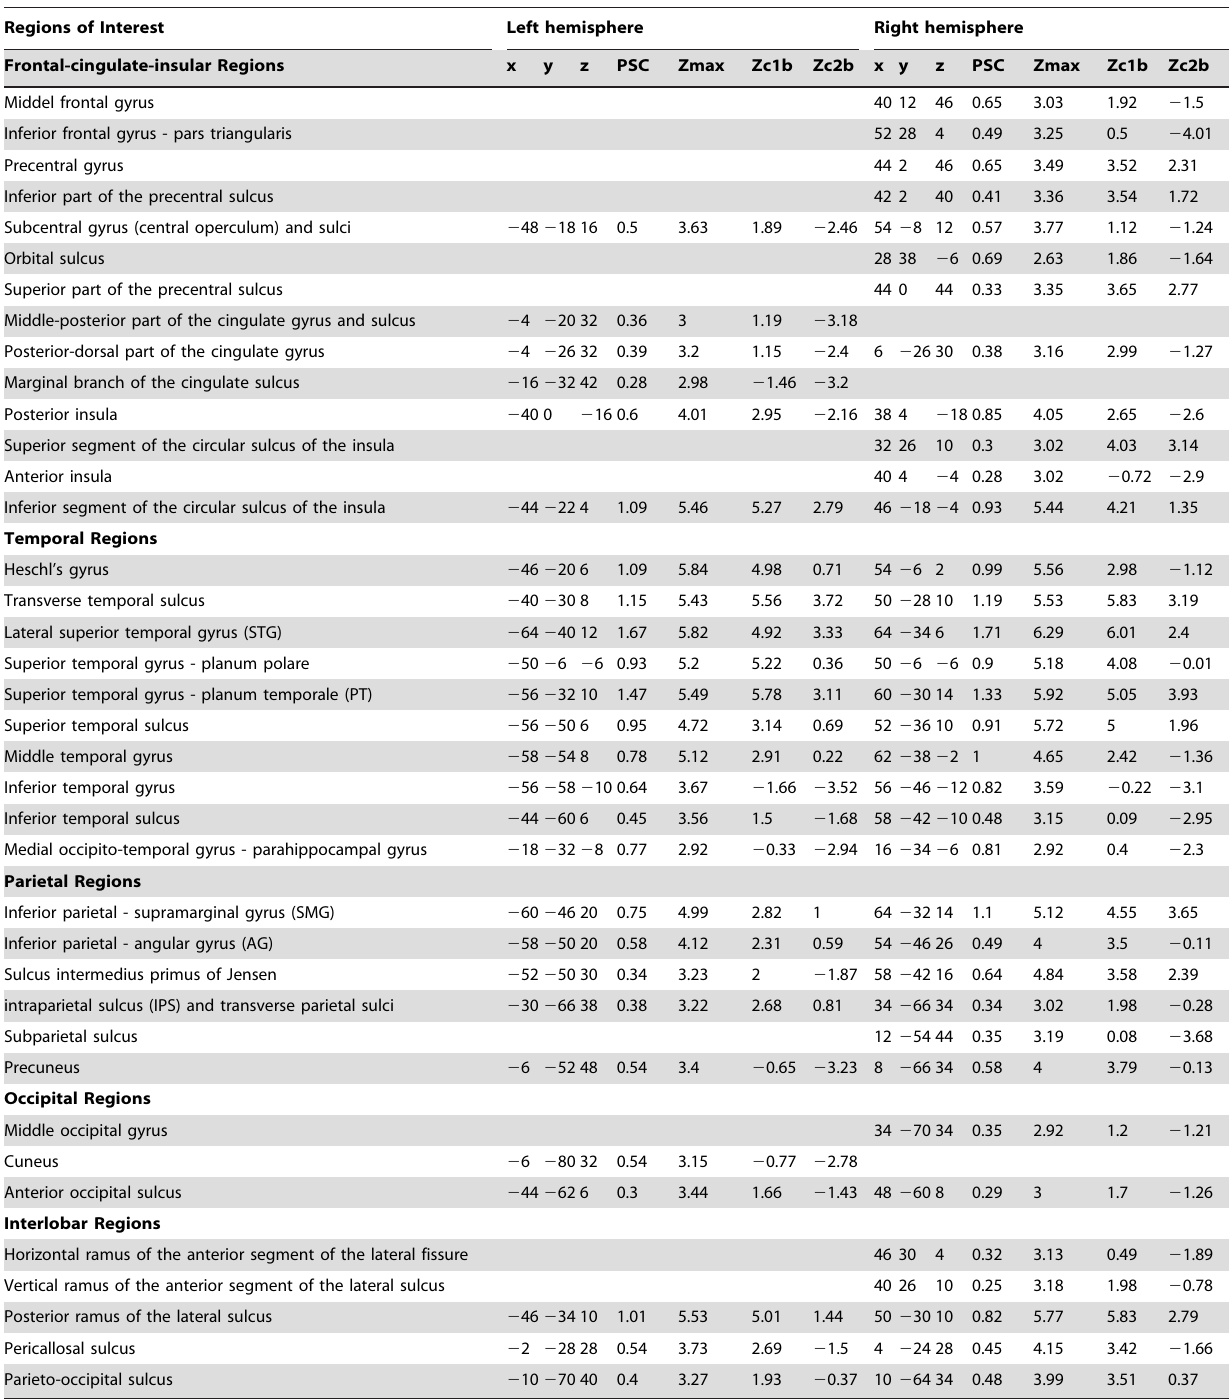
Table 2. Brain regions activated in the Cue + Novel + Standards vs. Cue + Standards contrast.